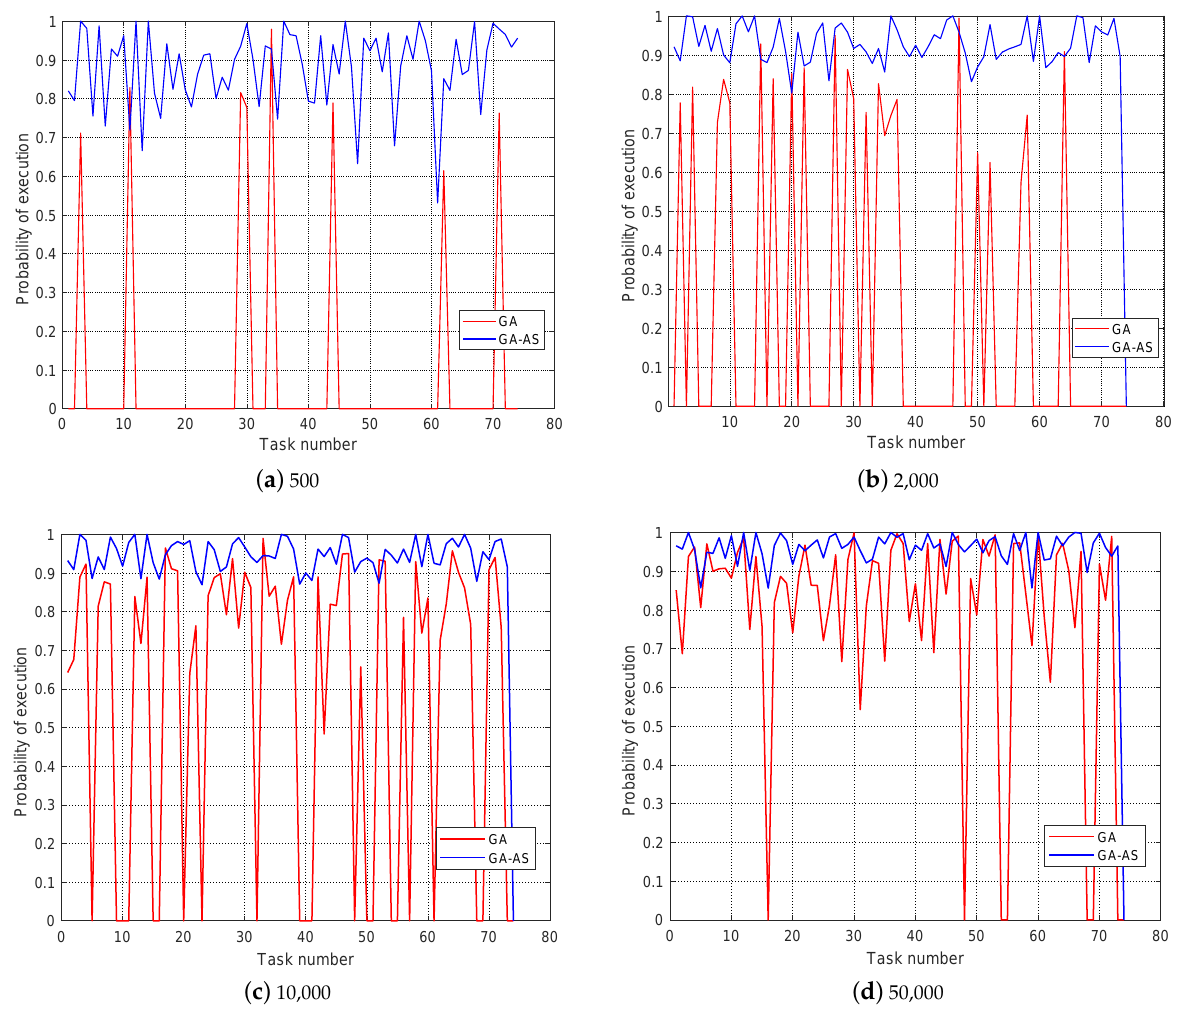
Figure 5. Task execution probability of GA-AS and GA with different population